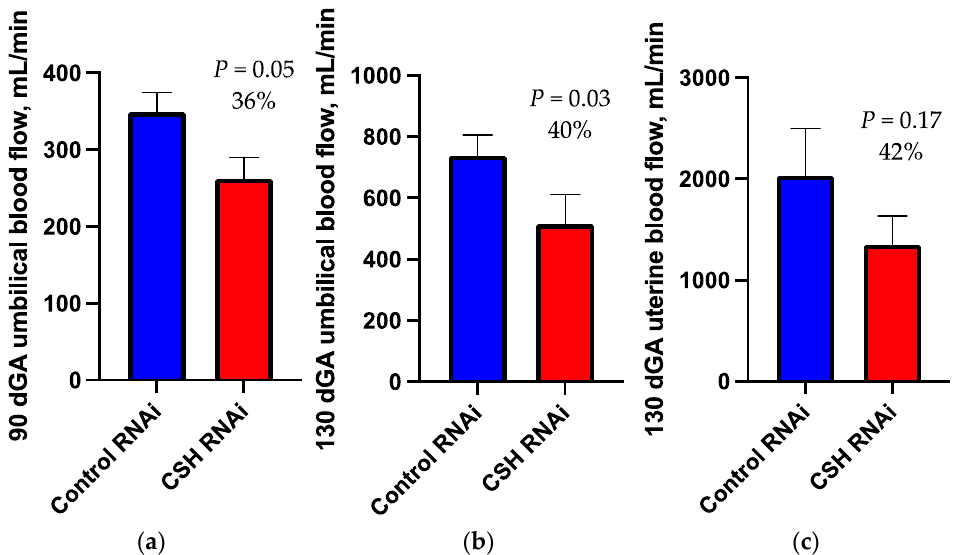
( a ) ( b ) ( c ) Figure 1. Measures of blood flow: ( a ) umbilical blood flow as assessed by Doppler ultrasound at 90 dGA; ( b ) umbilical blood flow as assessed by the transplacental diffusion technique at 130 dGA; ( c ) uterine blood flow as assessed by the transplacental diffusion technique at 130 dGA. Data are shown as means ± SEM for all pregnancies in each treatment group. CSH, chorionic somatomammotropin; RNAi, RNA interference.